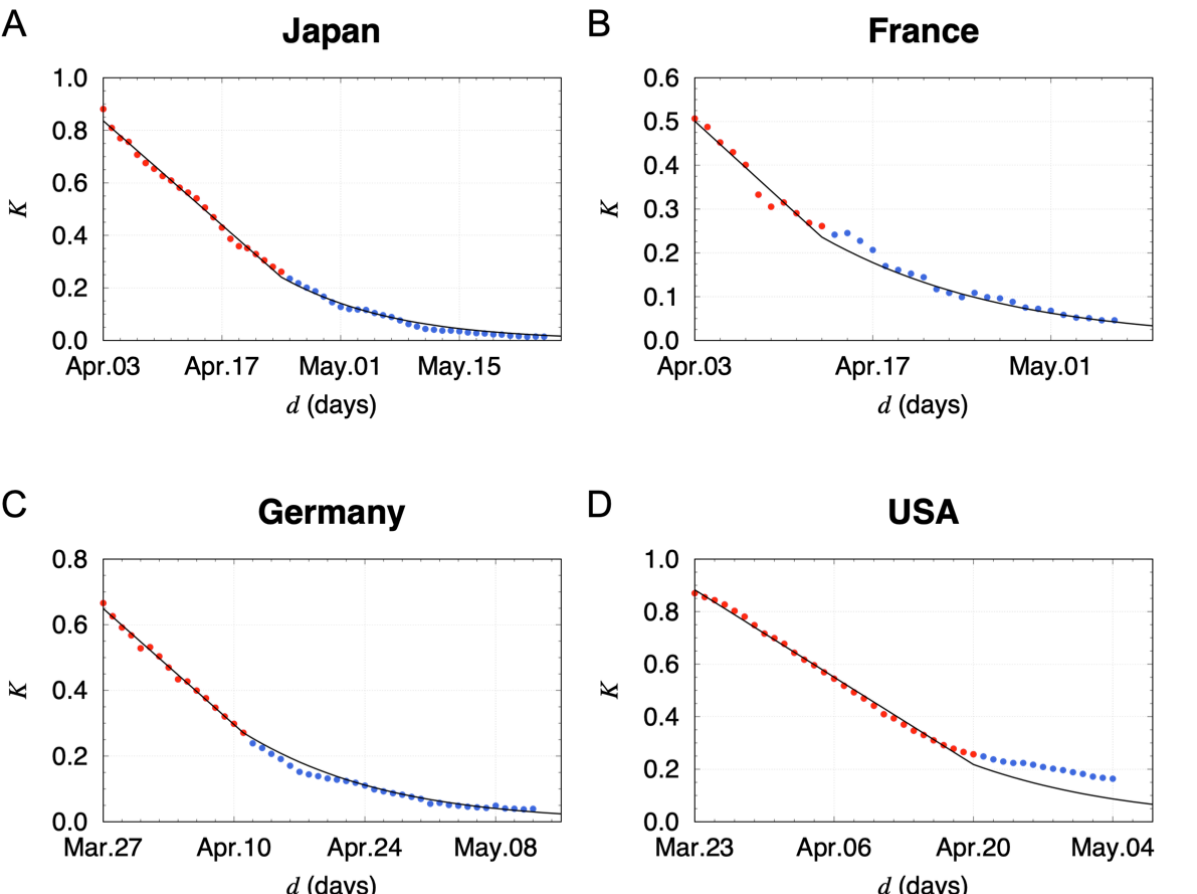
Figure 2. K values calculated by a phenomenological model with the constant attenuation assumption. (A) Model calculations and real data points for Japan. The slope K’ was obtained by a linear fit in the range of 0.25< K <0.9 using red points. The solid curve in the range of K <0.25 is estimated with the constant attenuation factor k calculated from K’ . The reference date was set for March 25, 2020. (B) Model calculations and real data points